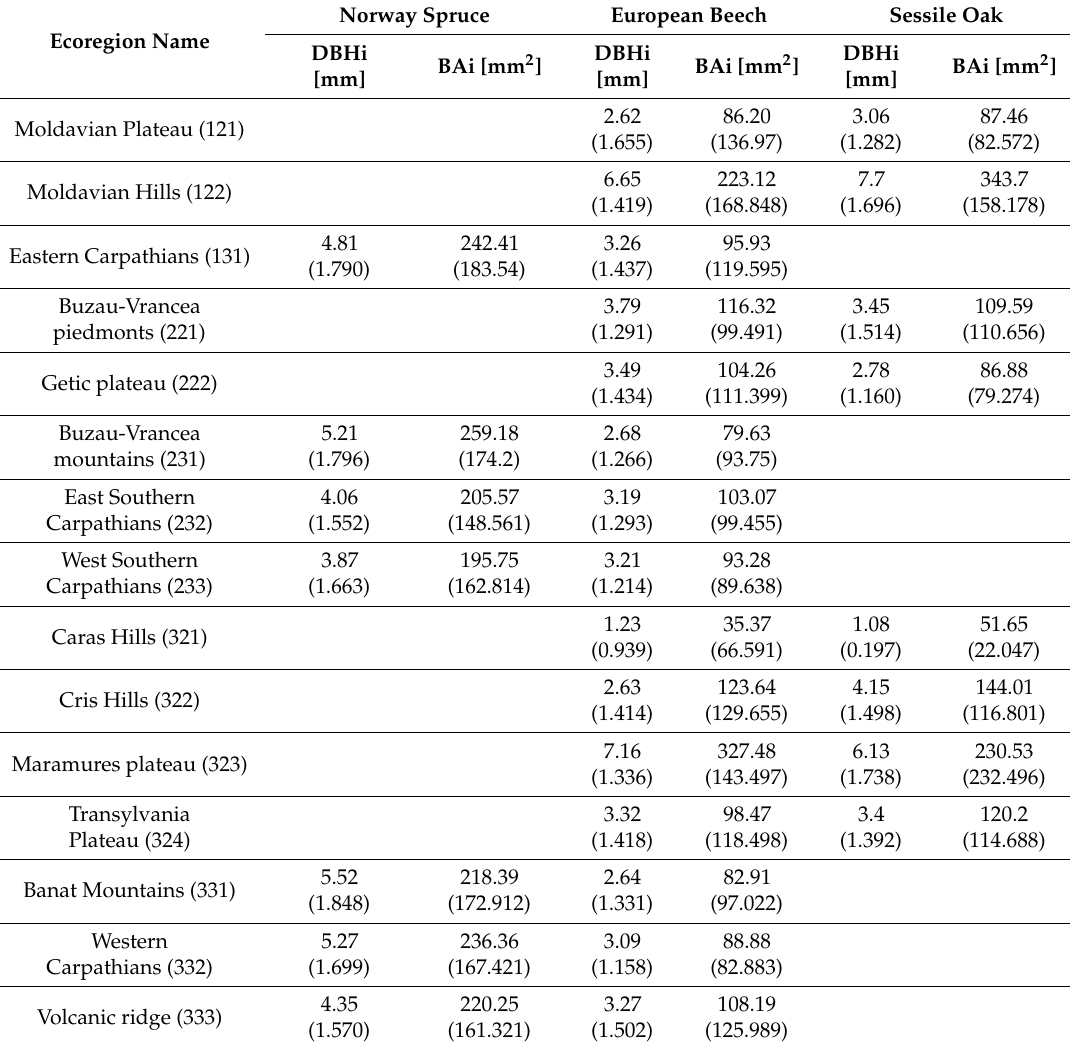
Table 3. Estimates and standard errors (in parenthesis) for DBH increment (DBHi) and basal area increment (BAi) for Norway spruce, European beech and Sessile oak by